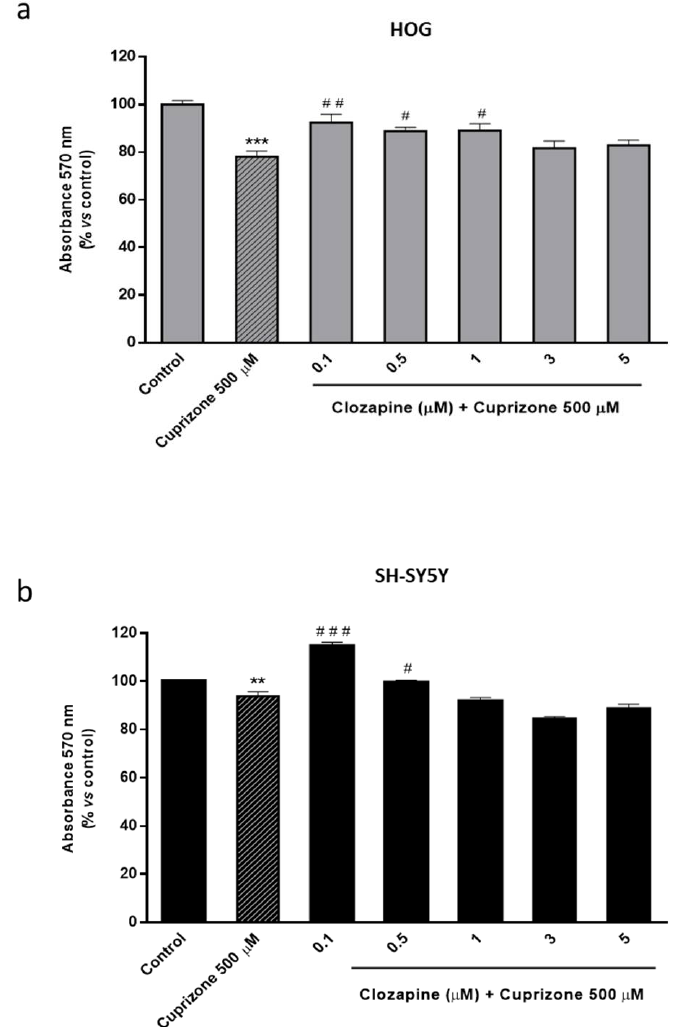
Figure 3. MTT assay in HOG ( a ) and SH-SY5Y cells ( b ) treated with increasing concentrations of CLO (0.1–5 µ M) followed by 24 h with 500 µ M of CPZ. Cell damage is represented as the percentage of viability versus control. Data are the mean ± SEM of five independent experiments. Significant differences were analyzed by a one-way ANOVA followed by post-hoc Tukey’s test. ** p < 0.01, *** p < 0.001 compared with control; # p < 0.05, ## p < 0.01, ### p < 0.001 compared with CPZ treat- ment.